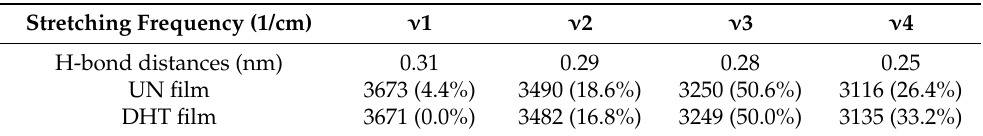
Figure 3. Gaussian deconvolution of FTIR spectrum of UN ( left ) and DHT ( right ) collagen film in the ν (OH) region in four components, corresponding to the H-bond distance of 0.25 nm (octane line, at about 3110 cm −1 ), 0.28 nm (sky blue line, at about 3250 cm −1 ), 0.29 nm (blue line, at about 3460 cm −1 ) and 0.31 nm (teal line, at about 3670 cm −1 ). The fitted curve is shown as the green (UN) or red (DHT) line, closely overlapping the experimental curve (black line). Table 2. Hydrogen bond distances of uncrosslinked and cross-linked collagen matrices in the 2400– 4000 cm − 1 spectral